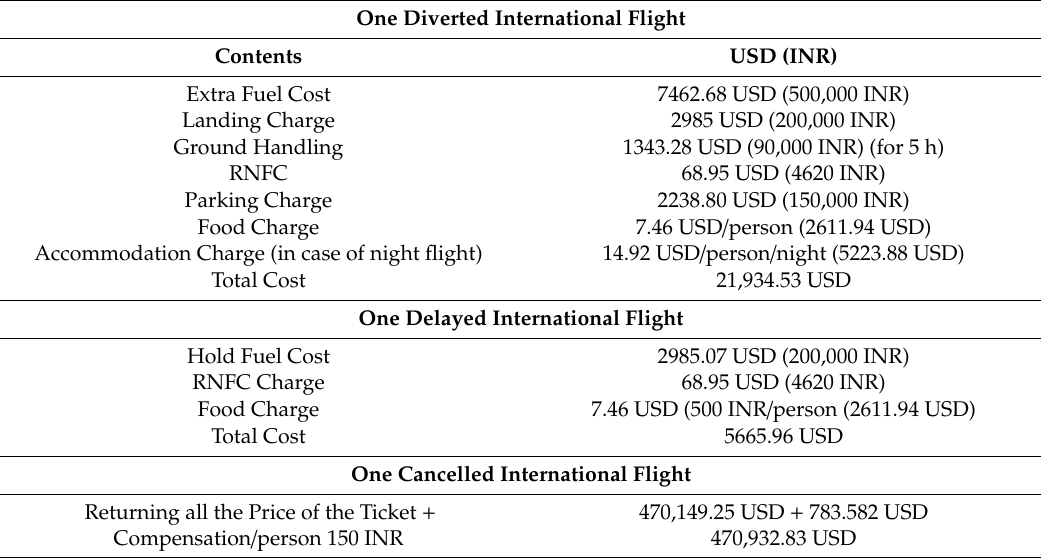
Table 3. Breakdown of charges for international flight operations.